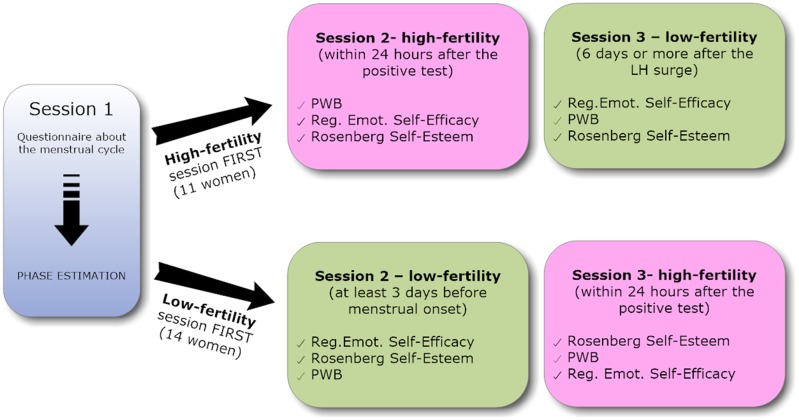
Design of the study.